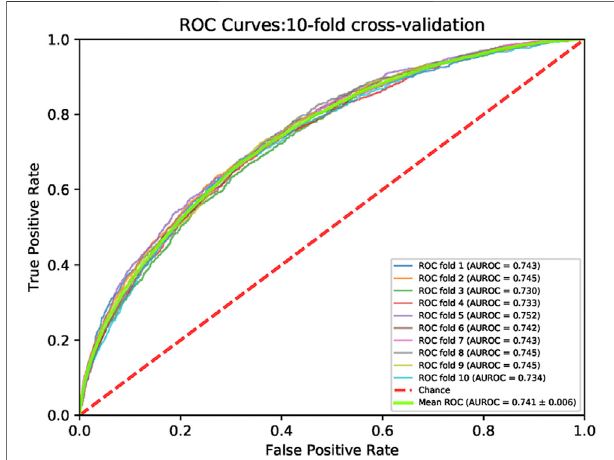
FIGURE 4 | The ROC curves of 10-fold cross validation on the train set. The minimum AUROC value cross validation is 0.730 at the fi rst fold. The maximum value of the cross validation is 0.752 at the ten-th fold. The green line represents the ROC curve of the cross validation mean. The mean valueofAUROCis0.741.ThereddottedlineisacontrollineonwhichAUROC (cid:1)